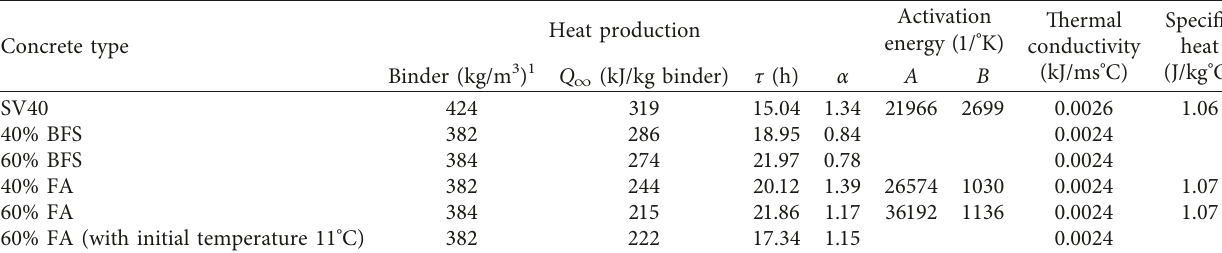
Table 2: Parameters for thermal